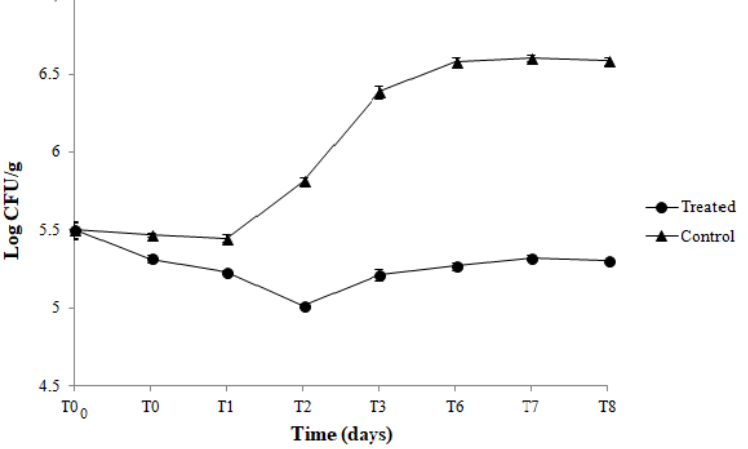
Figure 5. Total viable counts of mesophilic aerobic bacteria during the storage at 4 °C of hamburgers packed with CNF-Nis+PLA active films (treated) and CNF/PLA control films (control).